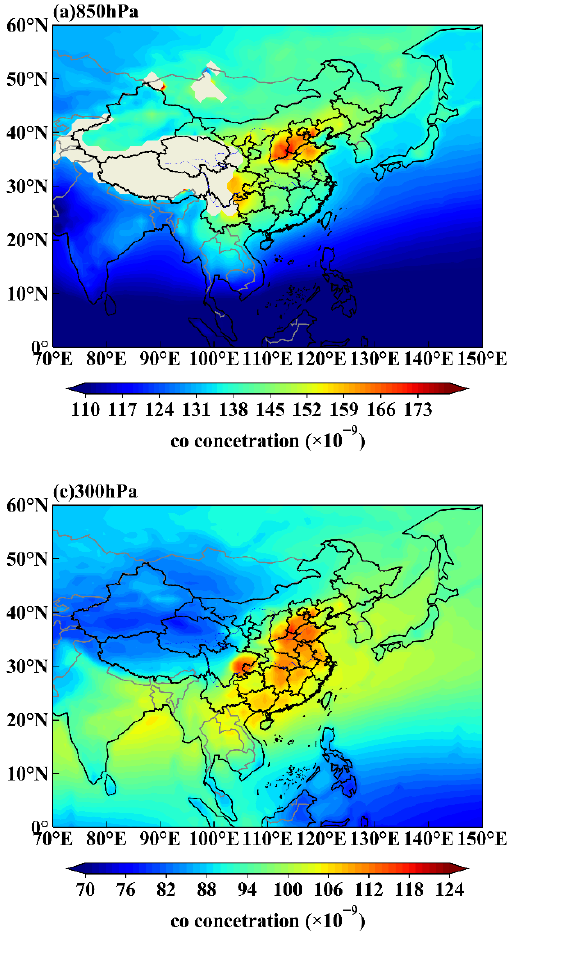
Figure 6. Spatial distribution of average CO concentration in different barometric layers in East Asia from September 2002 to December 2021. ( a ) 850 hPa; ( b ) 500 hPa; ( c ) 300 hPa; ( d ) 150 hPa. Table 2. From September 2002 to December 2021, the mean, variance, and standard deviation of CO in different pressure layers in East Asia.